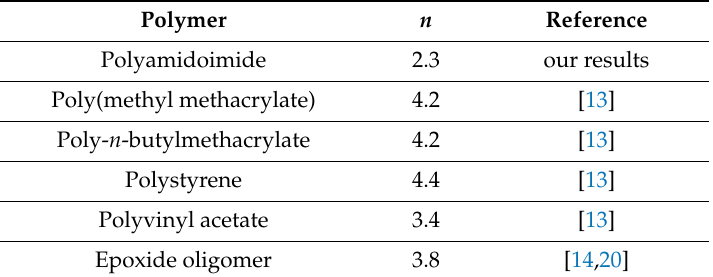
Table 5. Exponents in the McLeod equation.